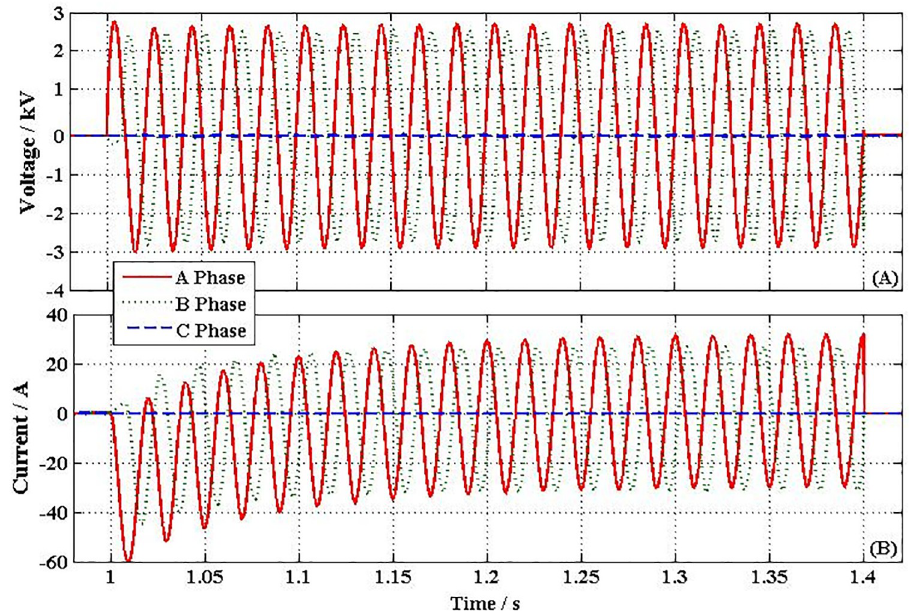
Fig 12. Transient performances curve of NFFCLs 1 . (A) Voltage of single series capacitance (B) Output current of H- bridge